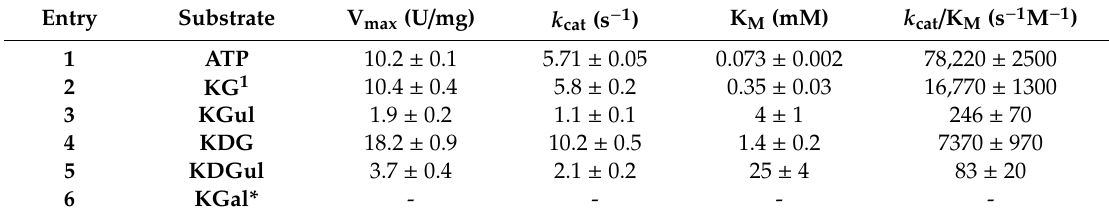
Table 2. Kinetic constants of the recombinant KGUK cnec